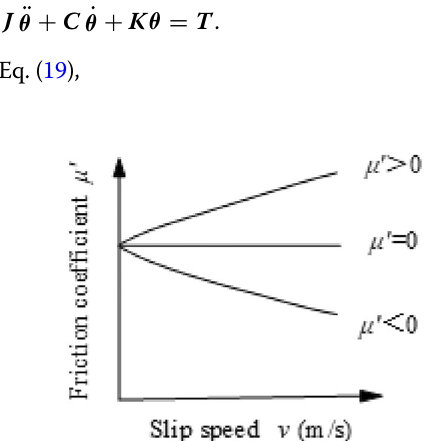
Figure 4 Defined as the gradient of the friction